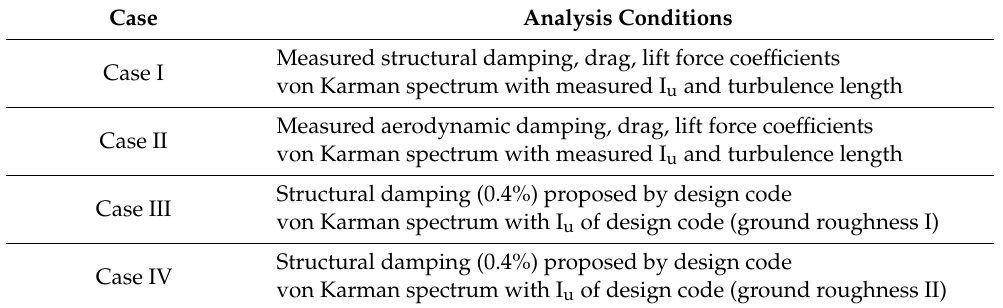
Table 5. Analysis cases.